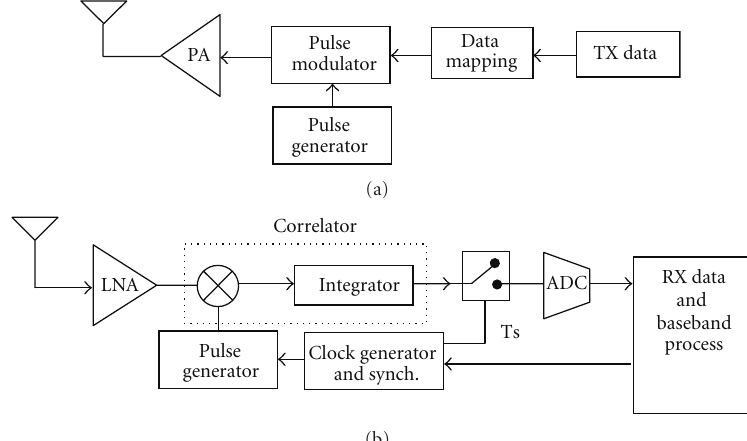
Figure 2: (a) In-body transmitter and (b) on-body receiver block diagrams for a capsule endoscope UWB communication system.